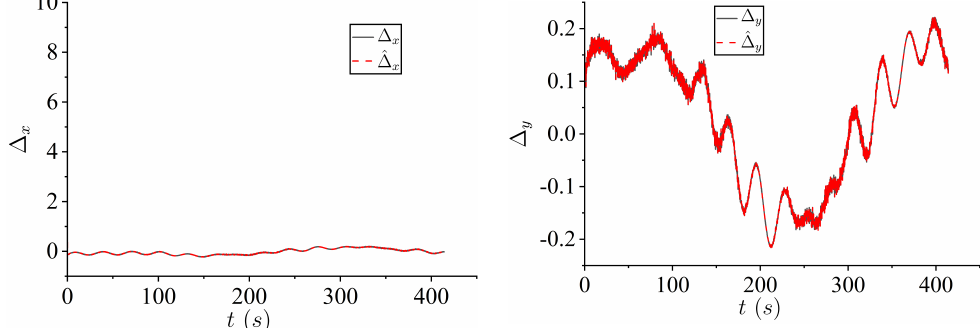
Figure 9. The estimation results of DO in Case